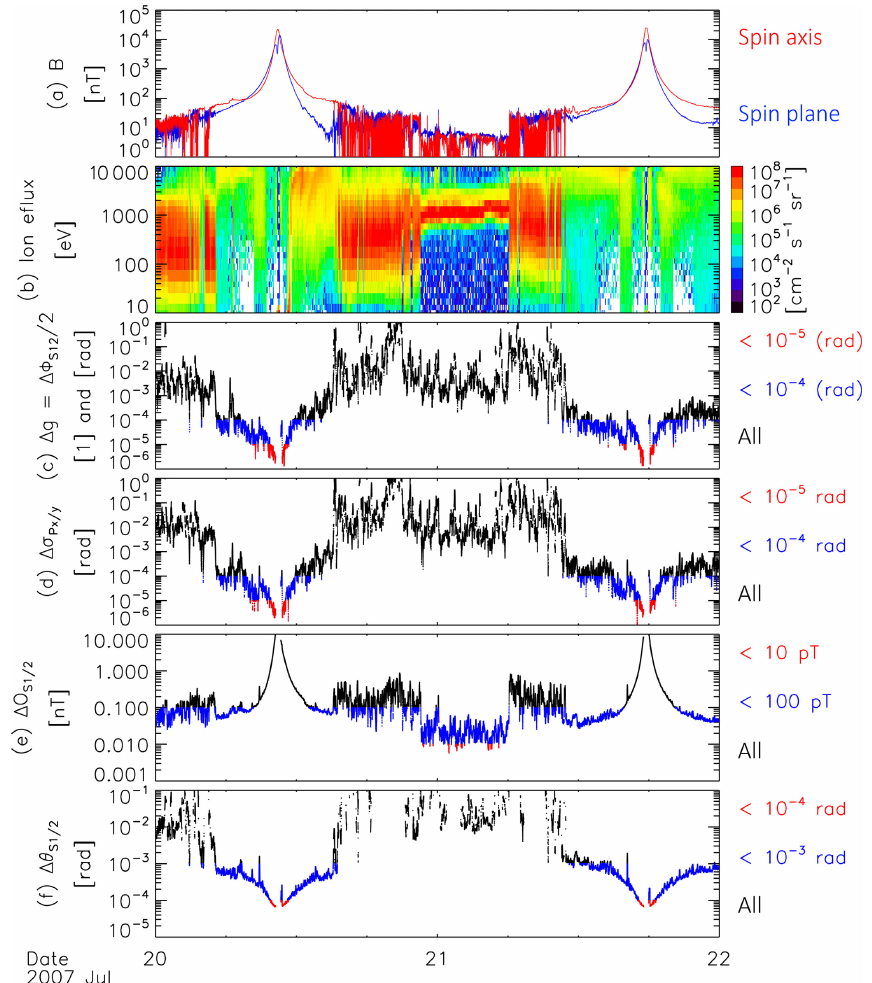
Figure 2. From top to bottom: (a) magnitude of the spin axis and spin plane magnetic fields in red and blue, (b) omnidirectional ion spectral energy flux densities, and (c–f) uncertainties of the estimates of the respective calibration parameters calculated in accordance with Table 2.